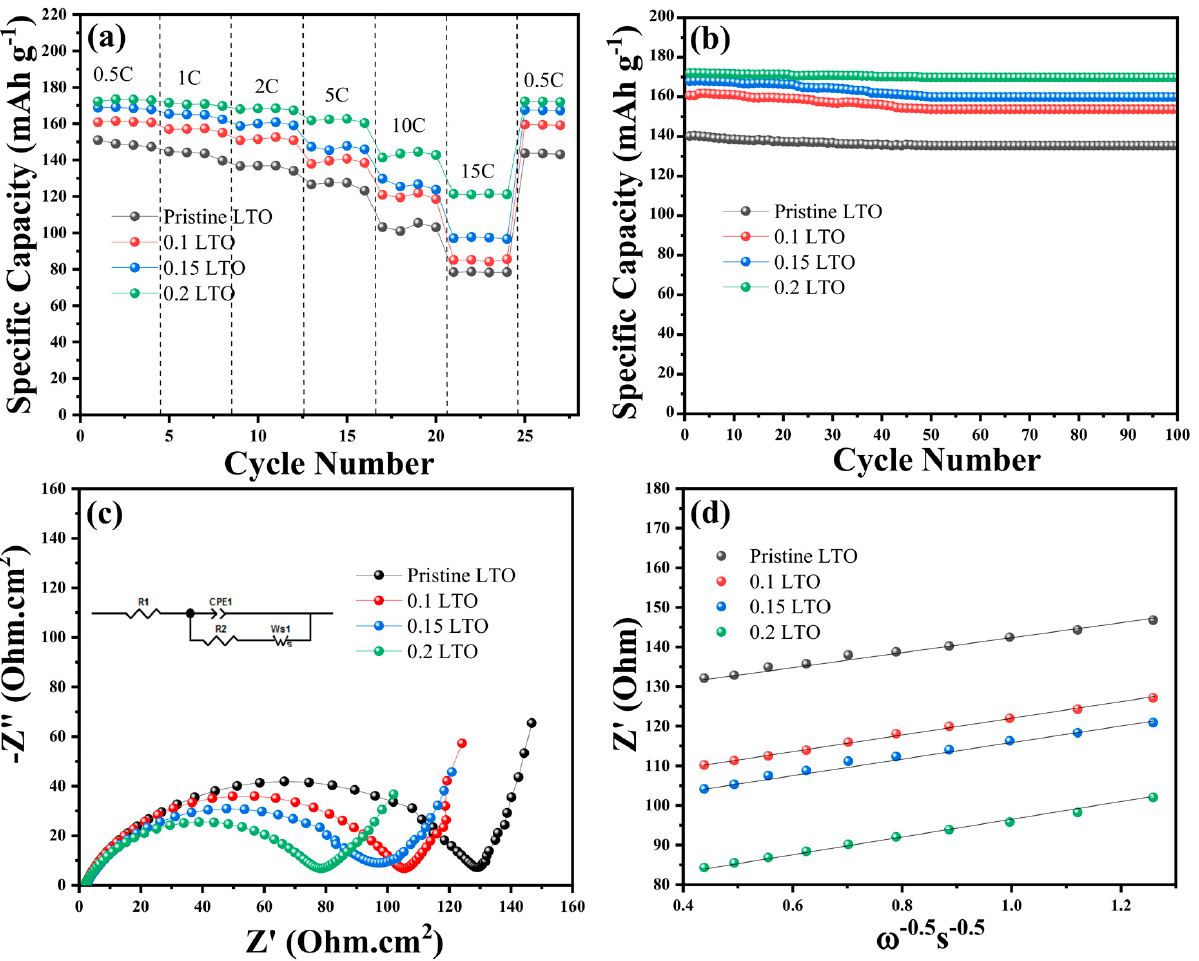
Figure 5. Electrochemical performance of pristine LTO and iodide-doped LTO: ( a ) capability in different current densities, ( b ) cyclic performance, ( c ) AC impedance spectra with an inserted equivalent circuit, and ( d ) Li + diffusion plot-rate capability ( a ), cyclability ( b ), Nyquist plot with inserted equivalent circuit ( c ), and Li + diffusion profile ( d ) of pristine LTO and LTO 0.2F.